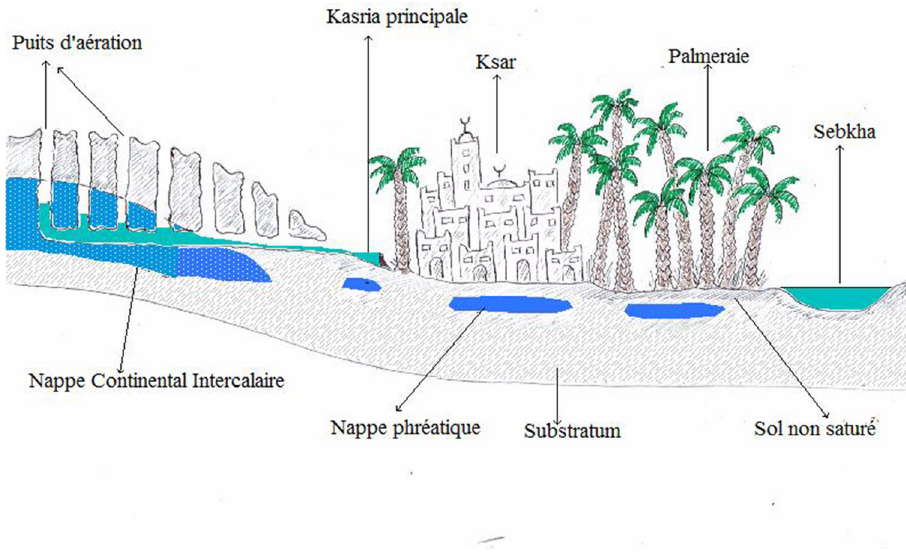
Fig. 7 Probable schema of a foggara of the oasis of Bouda before the putting into service of the boreholes (1987). (own